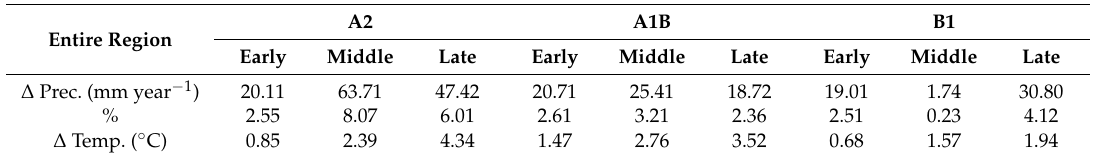
Table 2. Annual changes of precipitation and air temperature of the entire Great Lakes region over three future periods under three climate change